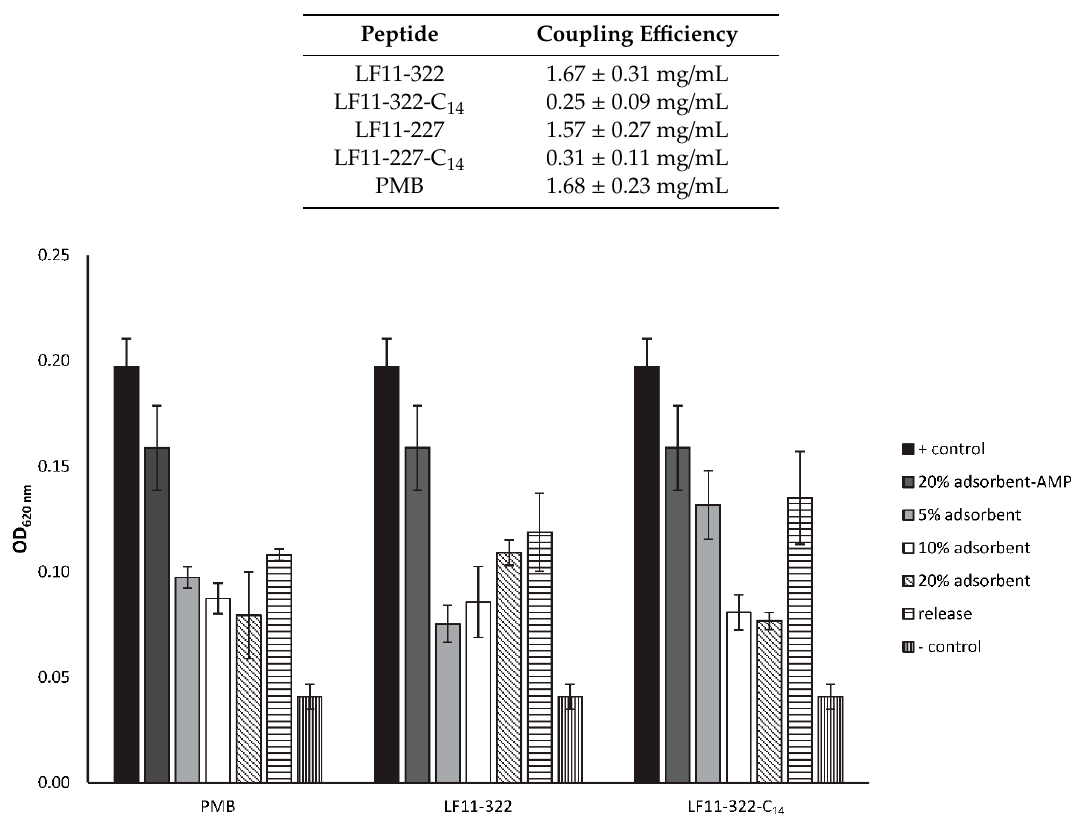
Table 5. Coupling e ffi ciency of AMPs in mg per ml adsorbent. PMB and AMPs were coupled on NHS-activated agarose beads. Coupling e ffi ciency was determined using the Pierce 660 nm protein assay.